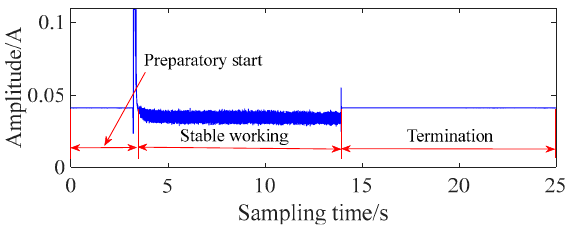
Figure 2. The working-current signal of the normal grille controller.